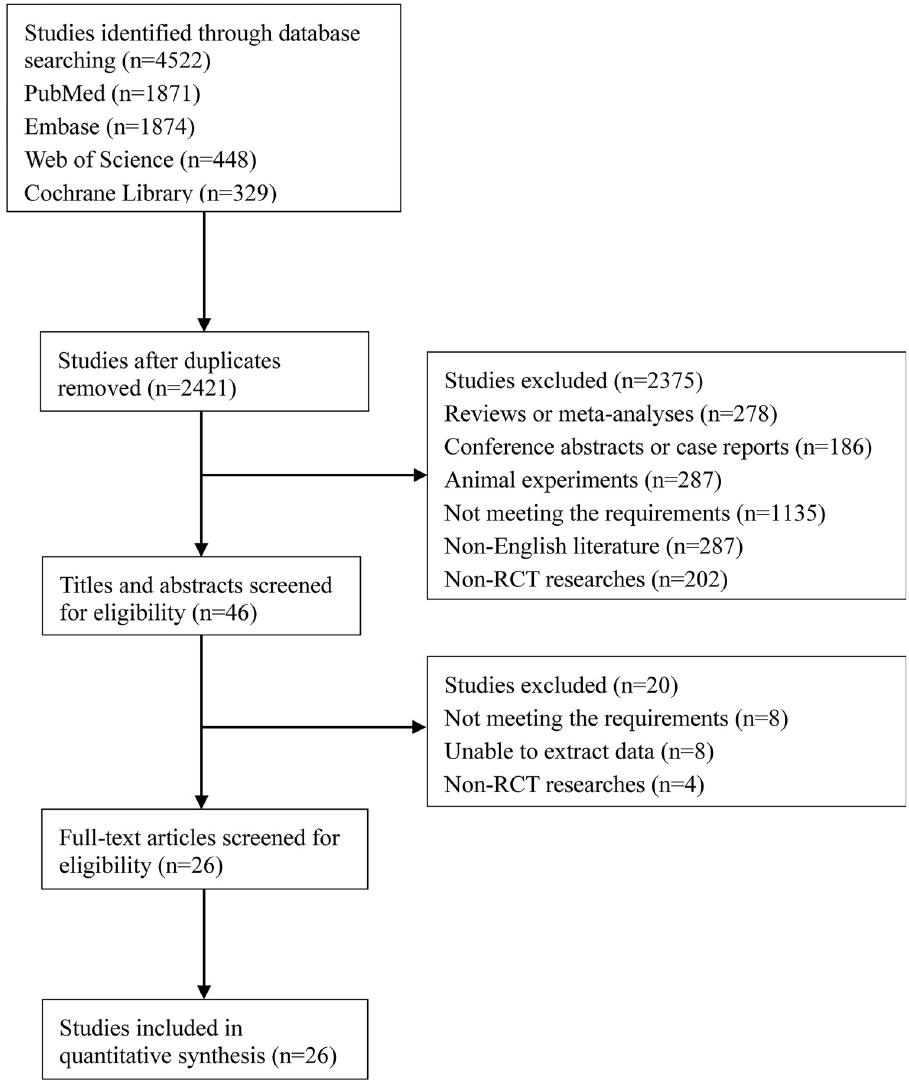
Fig 1. Flow chart for search